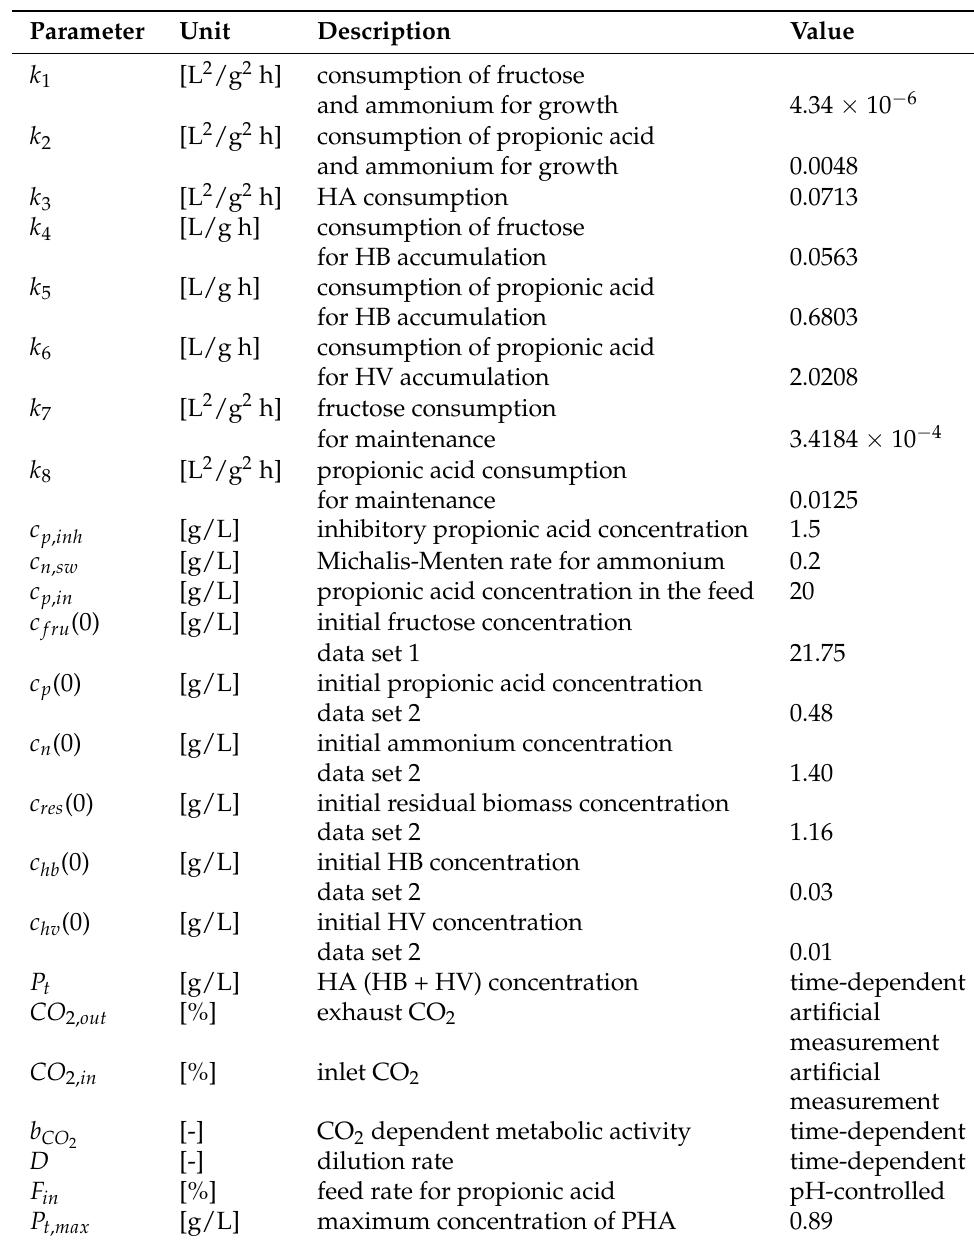
Table A1. Kinetic parameters, states and